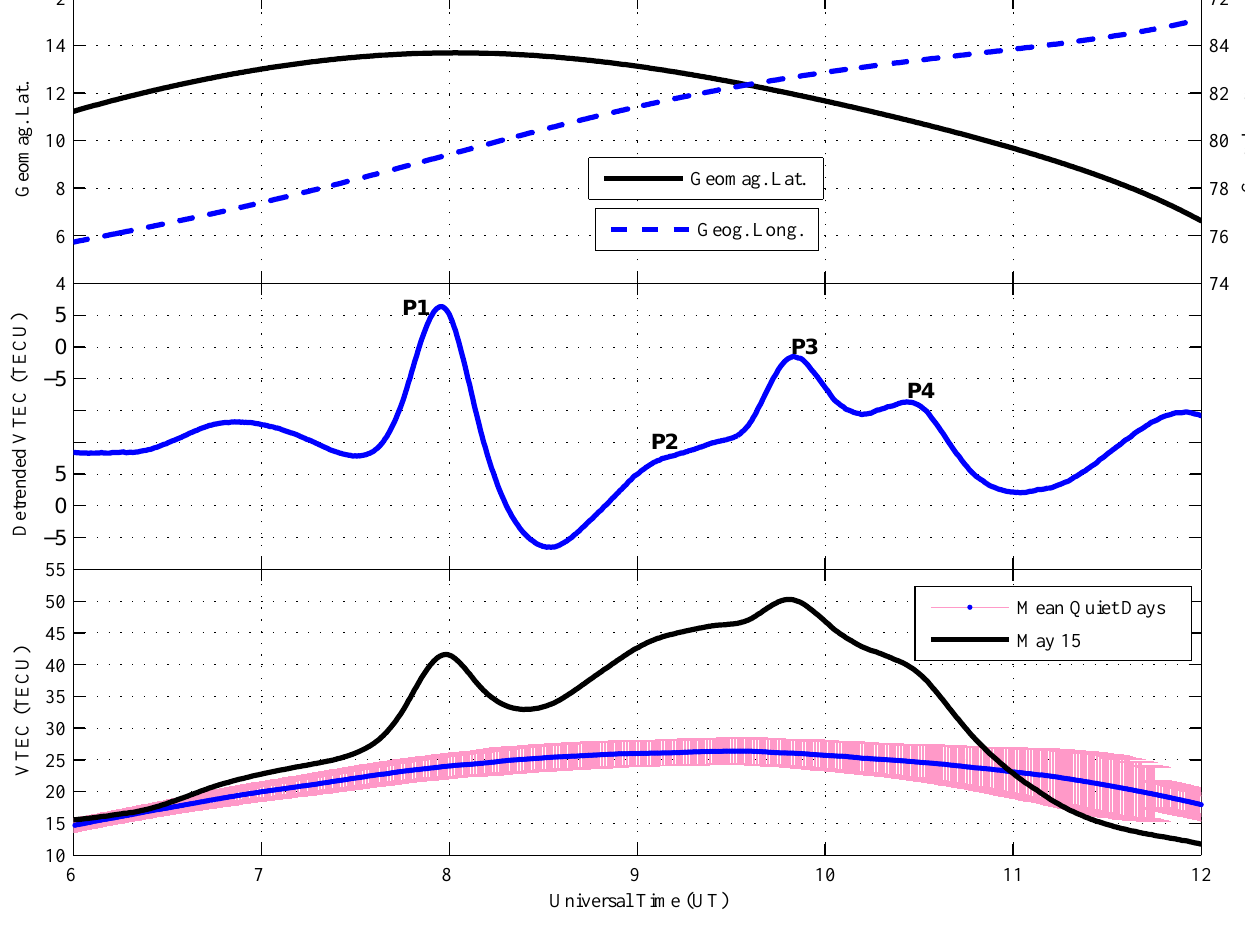
and 15 May 2005. Observations on 14 May serve as quiet time base values for comparison with storm time values on 15 May. Variations of fo F2 are given in the bottom panel and that of hm F2 in the top panel of Fig. 5, for 14 May (triangles with blue line) and 15 May (stars with red line),